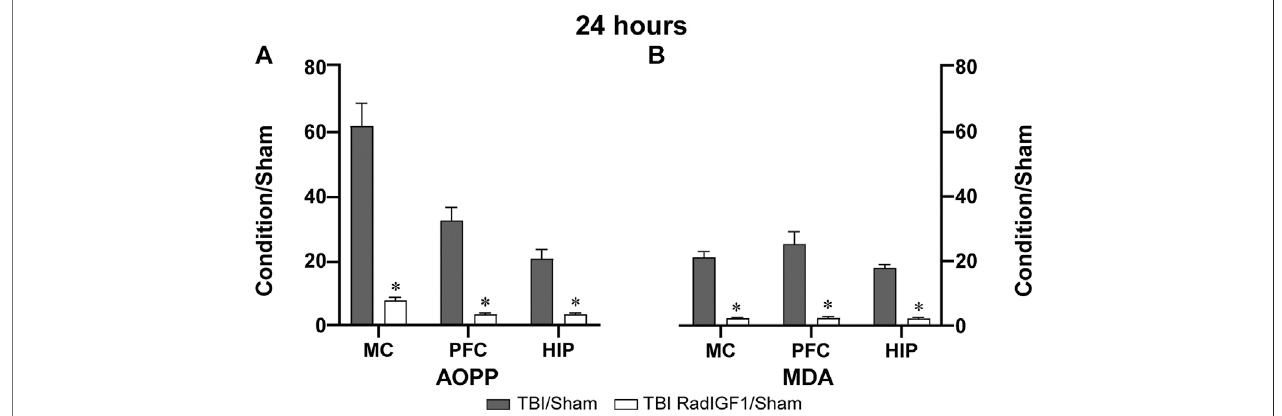
FIGURE 3 | Early IGF-1 treatment reduced TBI- induced OS biomarkers 24 h after injury. The graph shows the AOPP (A) and MDA (B) quanti fi cation as measurements of protein and lipid peroxidation, respectively, in brain areas neighboring the trauma area, such as Motor cortex (MC), Prefrontal cortex (PFC), and hippocampus (HIP). Results of positive control (TBI) and treated animals (TBI RadIGF1), referred as “ condition ” in the Y axes, were normalized to negative controls (Sham). Bars represent the mean ± SEM; n (cid:2) 4 – 6. *Different from TBI/Sham in each brain structure ( p < 0.05).